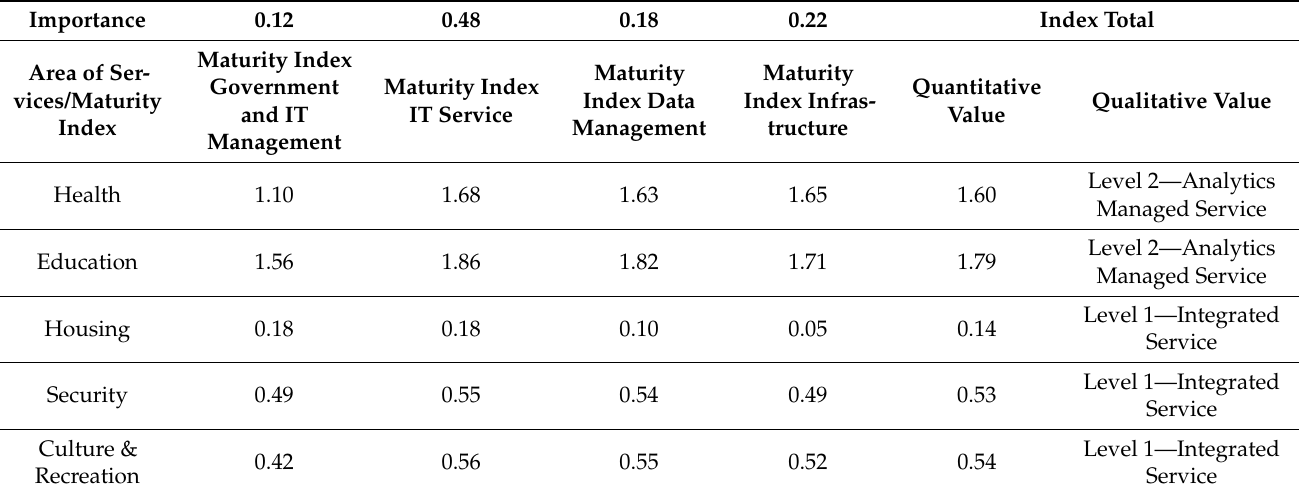
Table 12. Determine the level of maturity for each IT